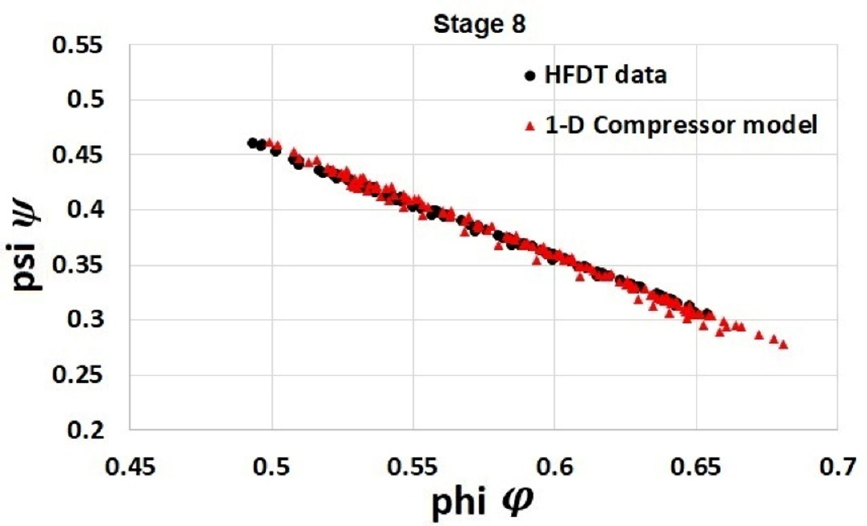
Figure 18. Comparison between stage-performance map (stage 8) predicted by HFDT and predicted by 1-D compressor model from 70–100% speed.